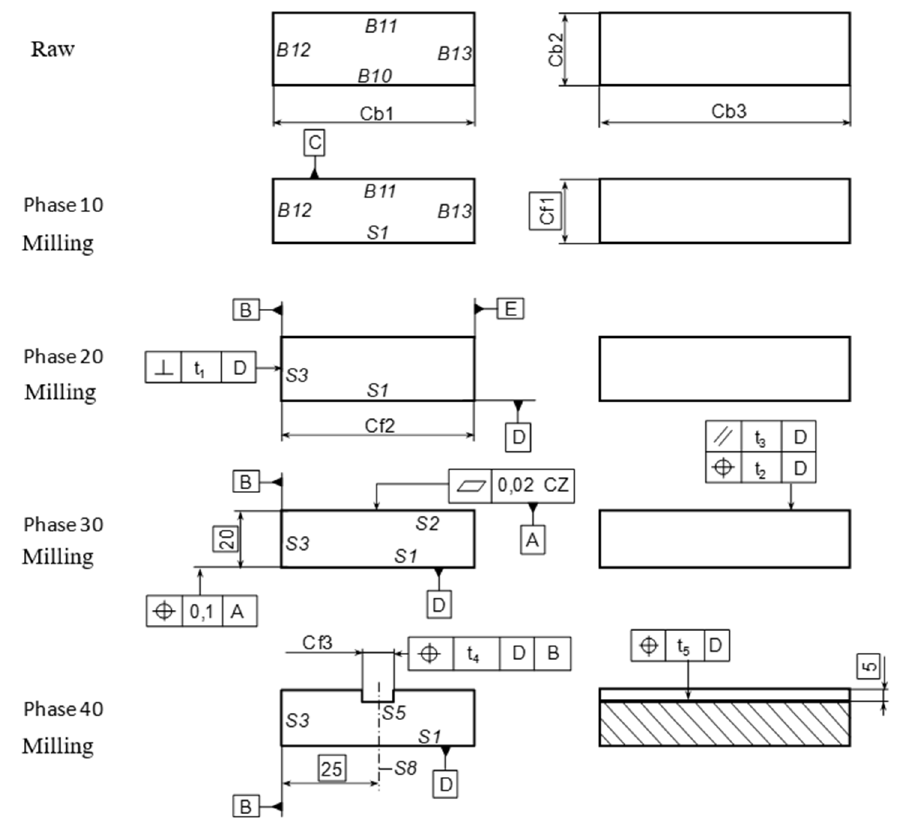
Figure 13. Phase